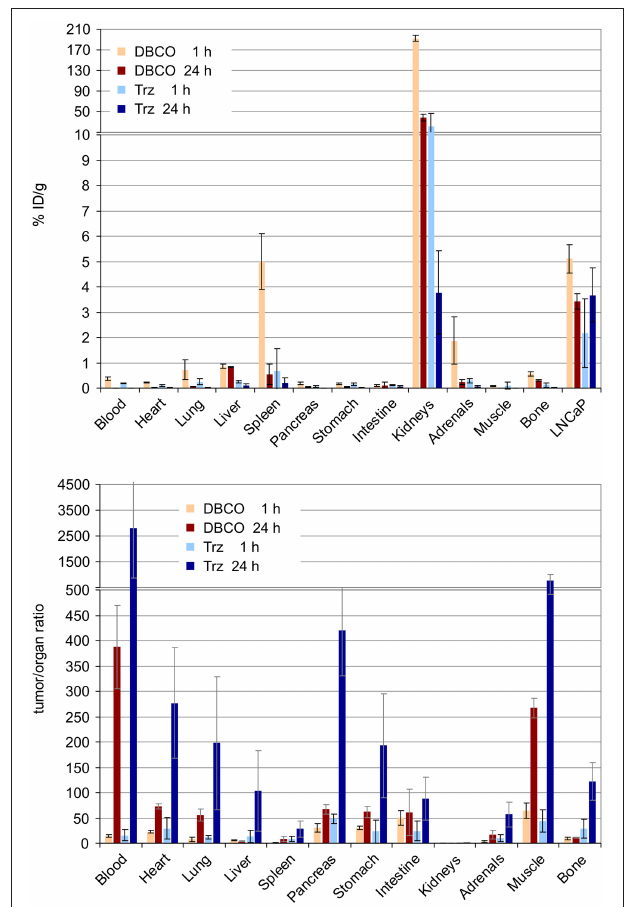
FIGURE 6 | Biodistribution (Top) and tumor-to-organ ratios (Bottom) for 177 Lu-DOTPI(DBCO-KuE) 177 Lu-DOTPI(Trz-KuE) 4 and 4 (1.1–4.5 MBq, 0.11–0.15 nmol, n = 3), determined 1 and 24h post injection in SCID mice bearing subcutaneous LNCaP (PSMA-expressing human prostate carcinoma)